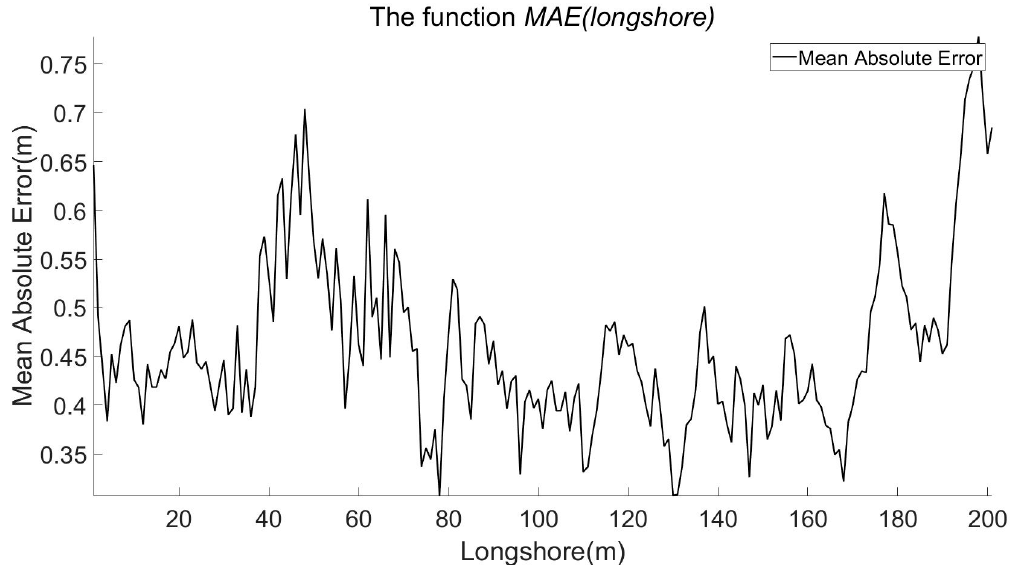
Figure 20. The diagram that MAE verses longshore.